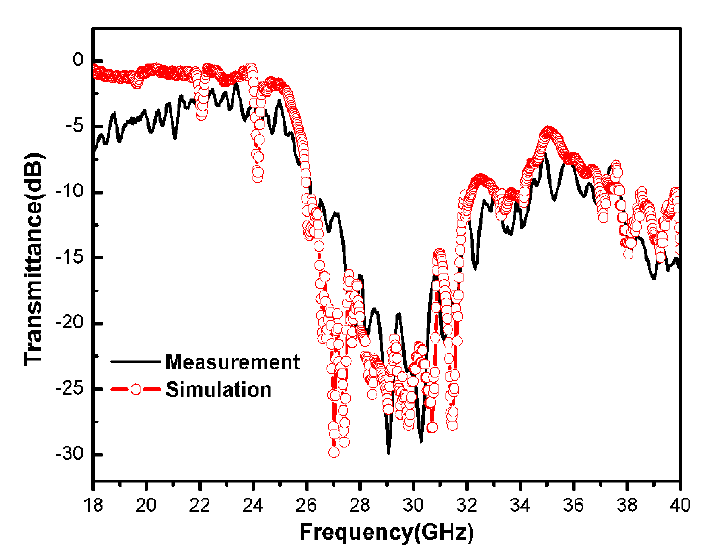
Figure 4. The measurement and simulation result of the PC with graded air spheres radii along the Г - Х <100>